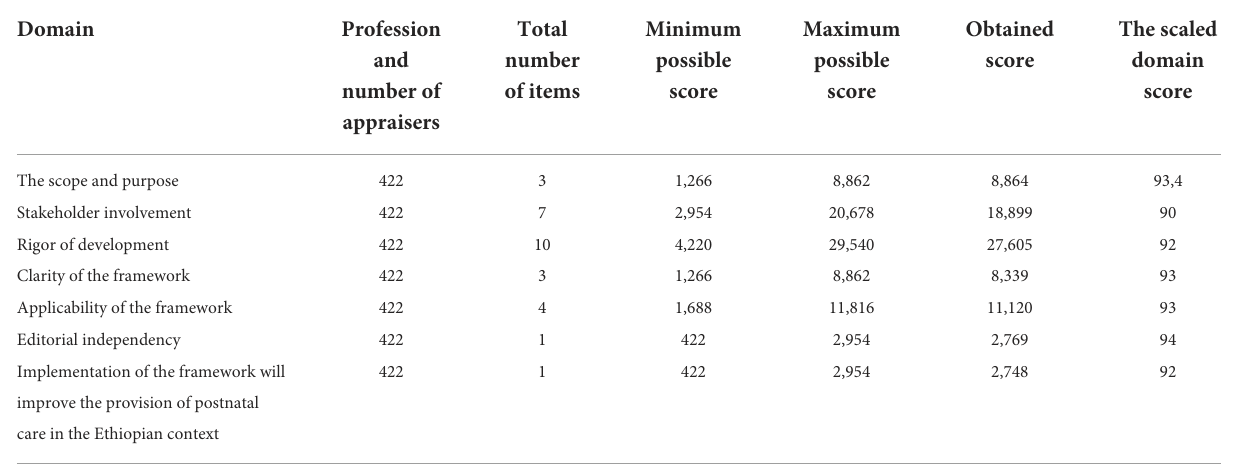
TABLE 2 Domain scores ( n =